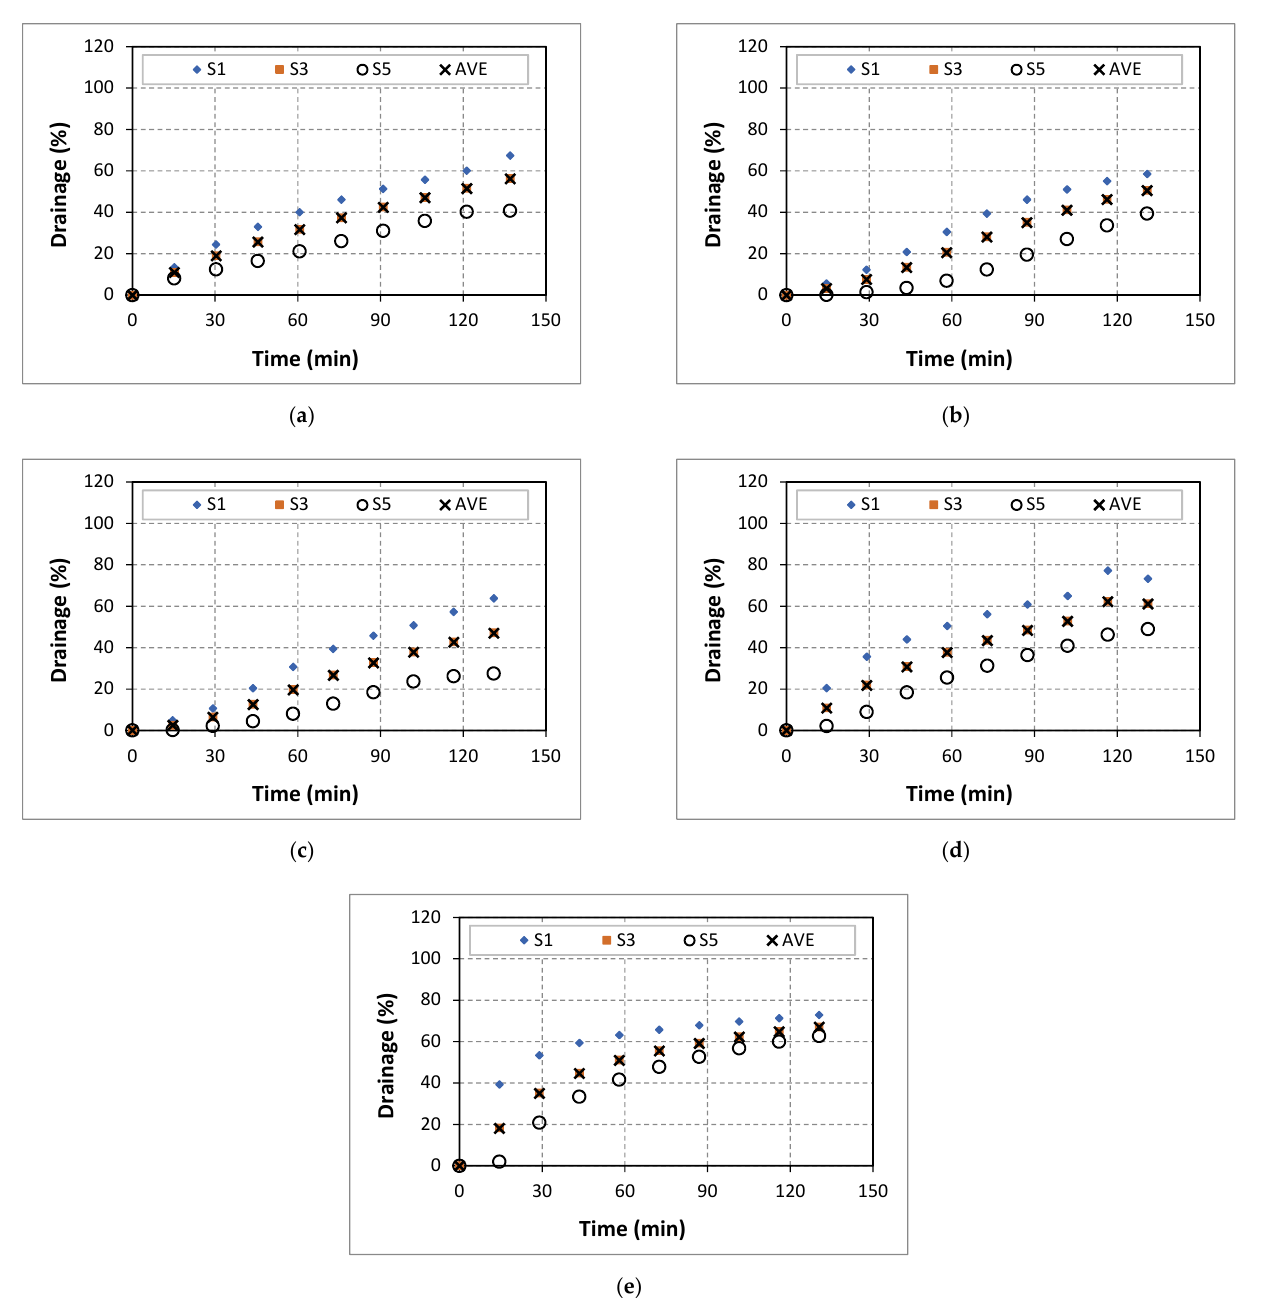
Figure A3. Drainage of 50% quality aqueous foam at different CaCl 2 concentrations: ( a ) 0% wt., ( b ) 5% wt., ( c ) 7% wt., ( d ) 9% wt., ( e ) 14% wt.